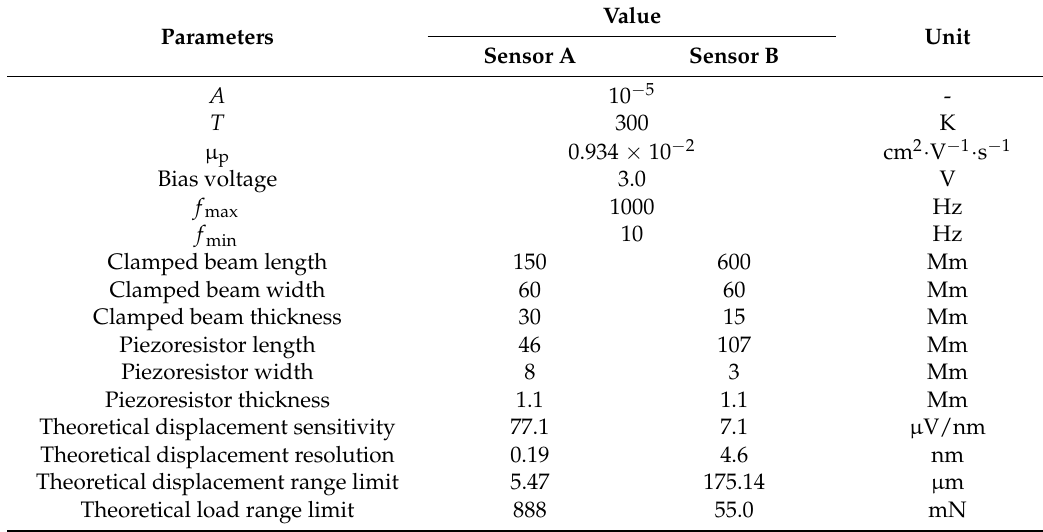
Table 1. Parameters of the two piezoresistive